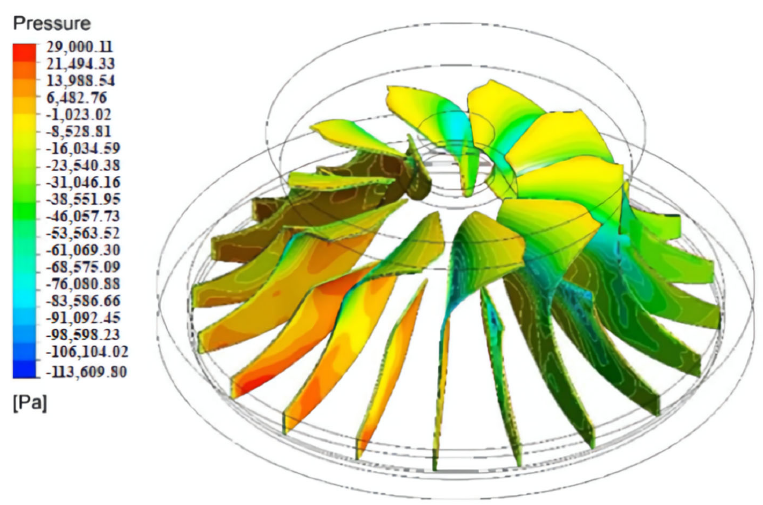
Figure 9. Pressure distribution of Type B.